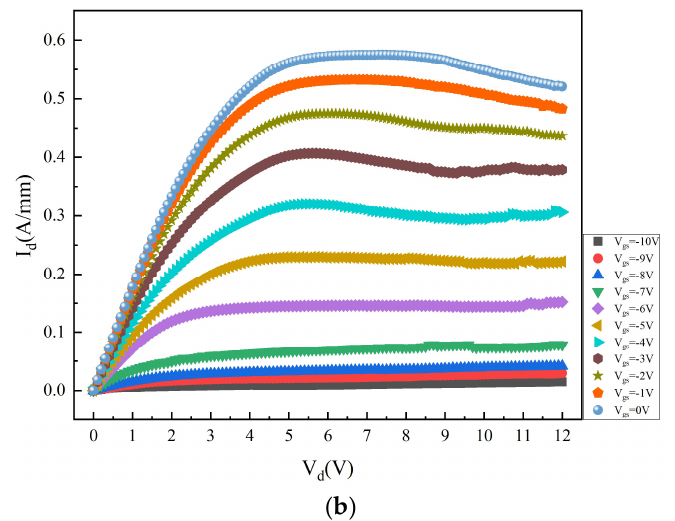
Figure 13. DC test result of the designed AlGaN/GaN HEMT device. ( a ) The gate leakage current test result, ( b ) the transmission curve test result .